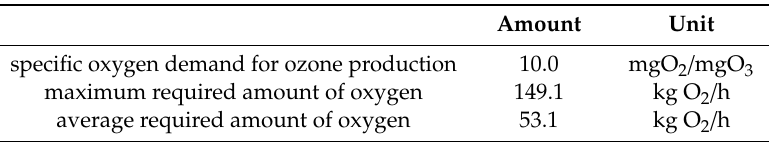
Table 3. Oxygen requirement of the advanced treatment for OMP